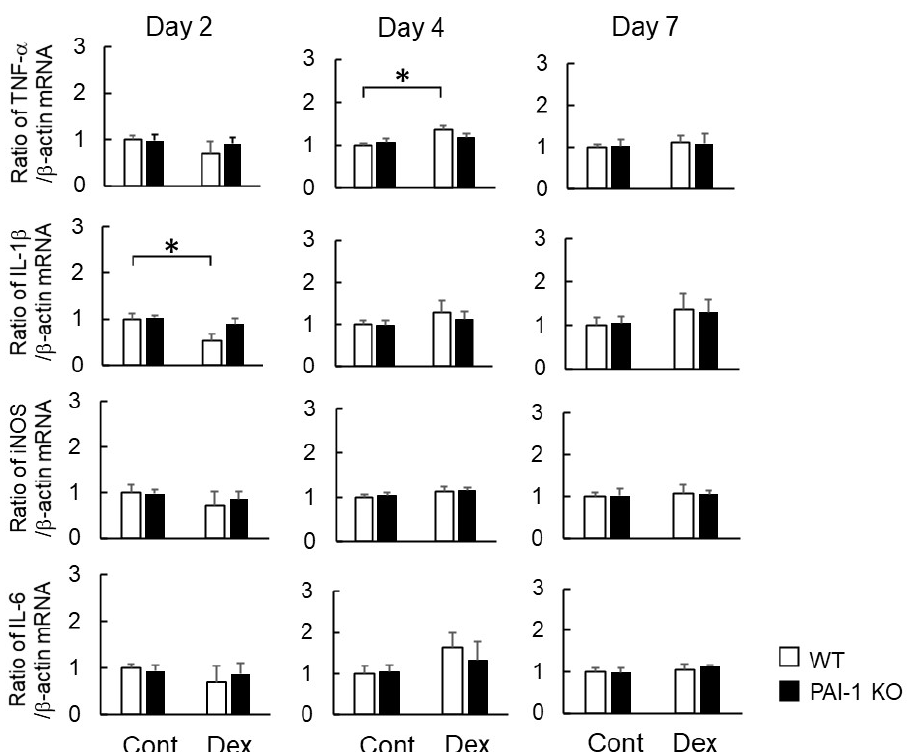
Figure 4. Effects of Dex and PAI-1 deficiency on the expression of M1 macrophage-producing factors at damaged sites after femoral bone injury. A real-time PCR analysis of the mRNA levels of TNF- α , IL-1 β , iNOS , IL-6 , and β -actin at damaged sites 2, 4, and 7 days after femoral bone injury in WT and PAI-1 KO mice. Data are expressed relative to β -actin mRNA values. Data represent the mean ± SEM: n = 5. * p < 0.05.